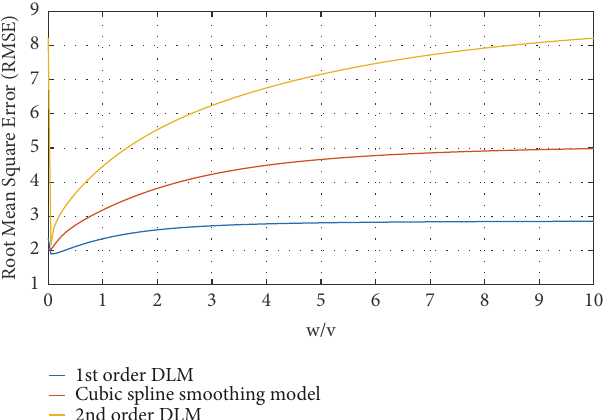
Figure 4: Influence of the signal-to-noise ratio (w/v) on one-step forecast accuracy of DLMs on traffic data on road section 4E.